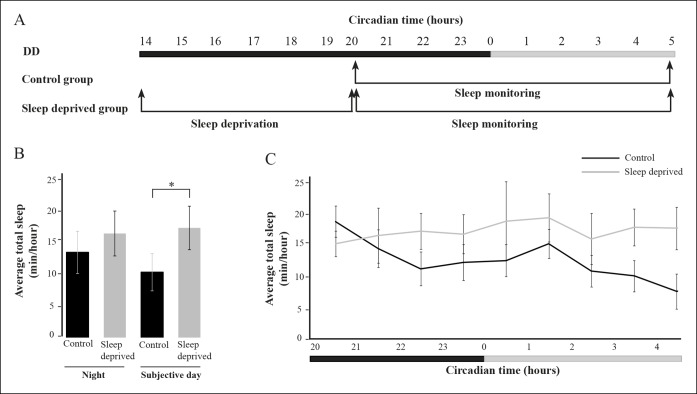
Sleep time is increased following sleep deprivation (SD).(A) At 6dpf, larvae were sleep deprived for 6 hr during the night under constant dark conditions (DD) and sleep time was monitored in the following nine hours. (B,C) Sleep was recovered in sleep-deprived larvae. Statistical comparisons were performed using Student’s t-tests (*p<0.05). Dark and gray horizontal bars represent night and subjective day, respectively.